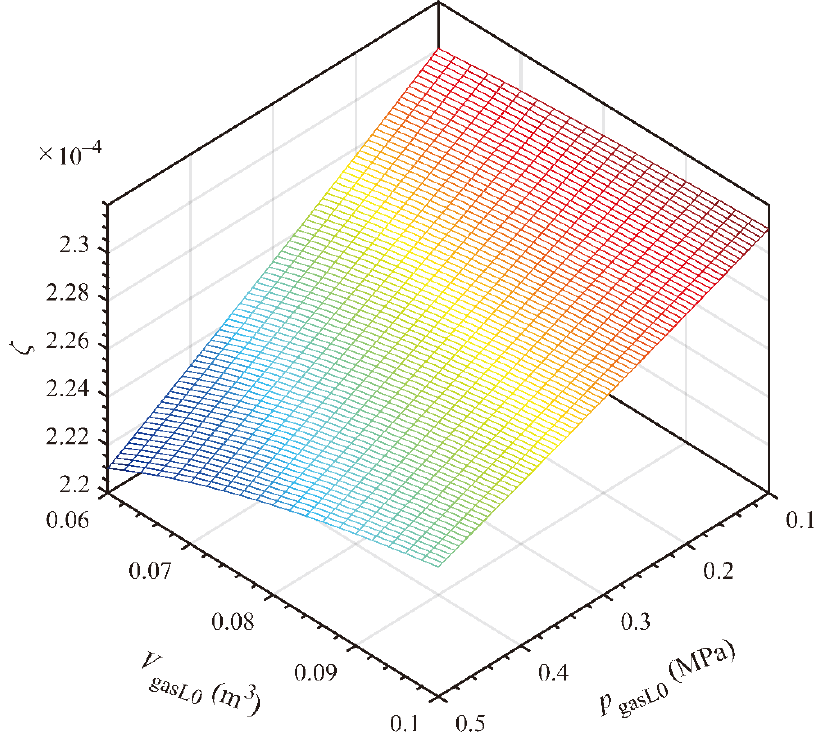
Figure 13. Effects of the pressure and volume of the low-pressure accumulator, p gasL0 and V gasL0 on the damping ratio, ζ .